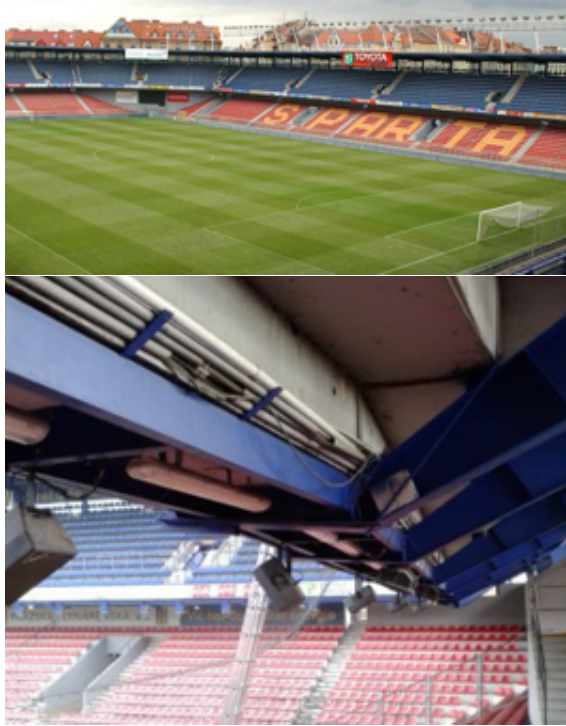
Figure 2. Platform construction: a) Letna Stadium – the overall view [8], b) Letna Stadium detail [1].